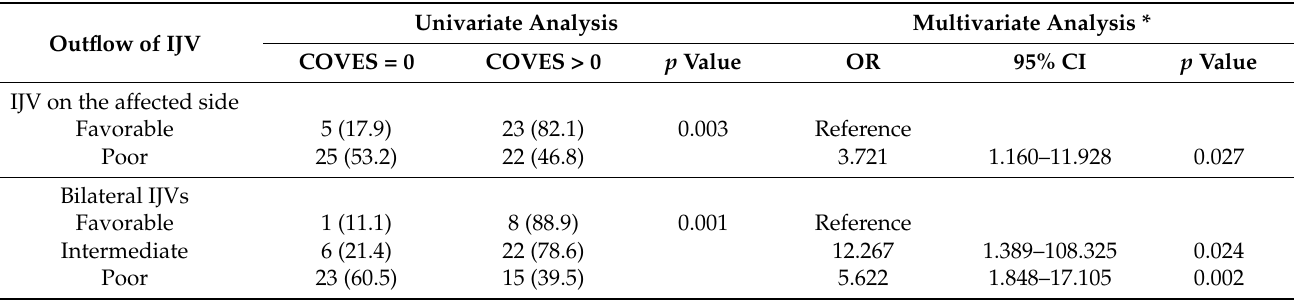
Table 5. Univariate and multivariate analysis to predict poor cortical venous outflow (COVES = 0) in the study cohort § .